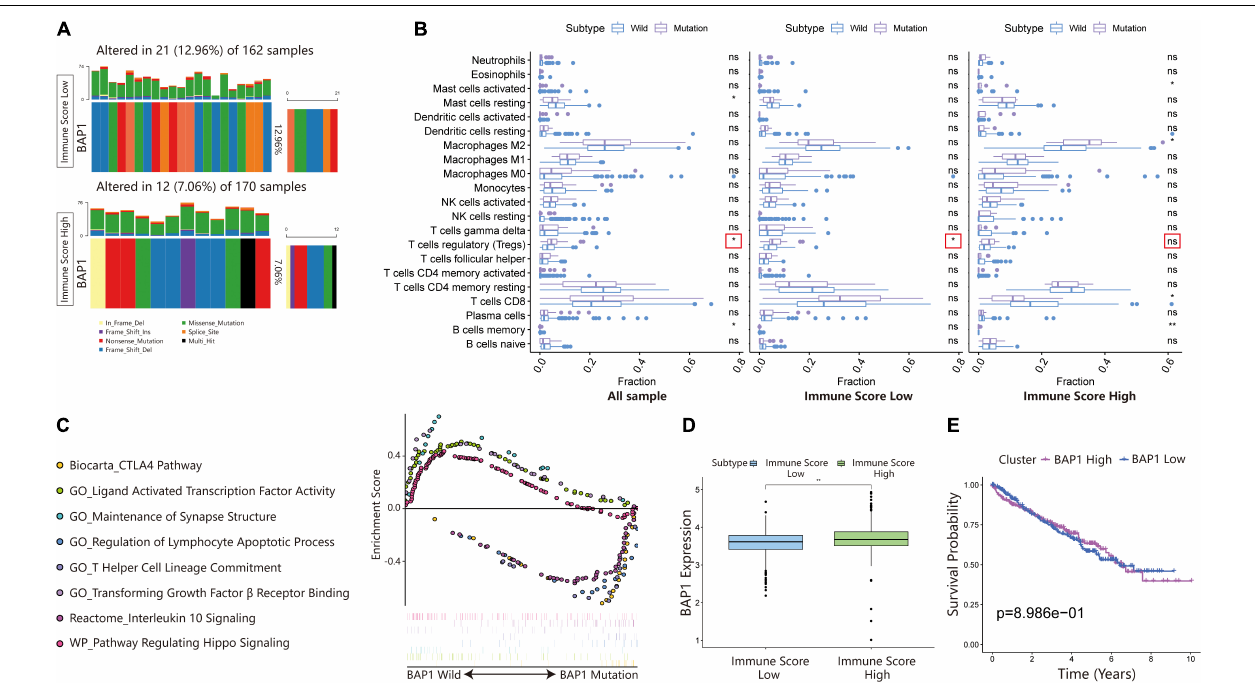
FIGURE 7 | Changes in BAP1 mutations in ISL and ISH groups. (A) Mutation frequency of BAP1 in the ISL group and ISH group. Each column represents an individual patient. The bar plot above the figure shows the TMB, and the number on the right represents the mutation frequency of each gene. (B) Effect of BAP1 mutation on tumor immune infiltrating cells in the ISL group, ISH group, and whole samples ( p -value, * < 0.05, ** < 0.01, ns > 0.05). (C) Gene set enrichment analysis comparing the BAP1 phenotype between the mutation group and wild-type group with FDR < 0.25. (D) The expression of BAP1 between the ISL group and ISH group ( p -value, ** < 0.01). (E) The survival curve shows that the expression level of BAP1 is not related to the prognosis of ccRCC